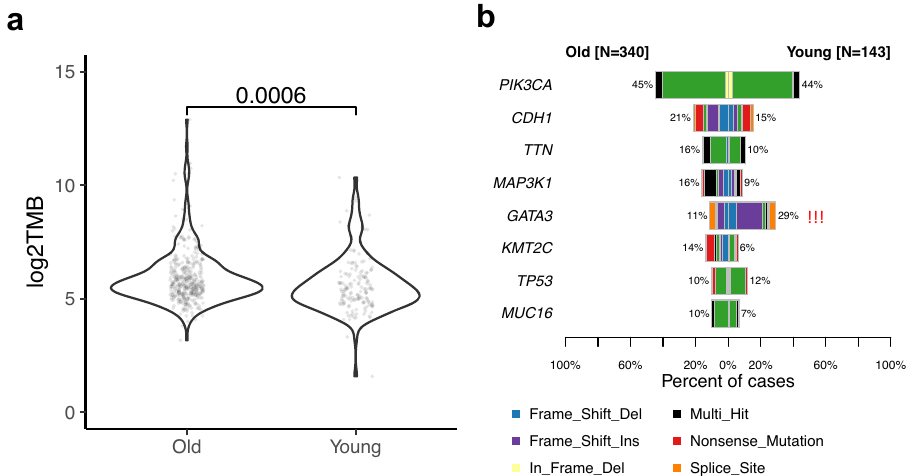
Fig. 3 Somatic mutation pro fi les between younger versus older TCGA patients. a Tumor mutation burden. P -values from Wilcoxon rank- sum test. b Somatic mutation frequency. Only genes with mutation frequency > 5% in both groups are shown. ***Fisher ’ s exact test p value <